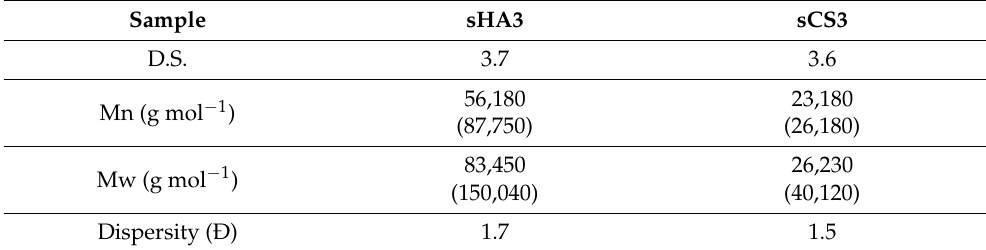
Table 2. Analytical data of the synthesized GAG derivatives.